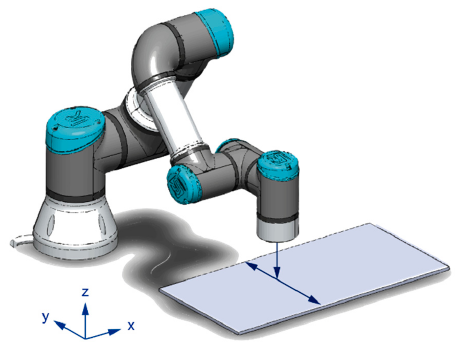
Figure 5. Scheme of experiments.